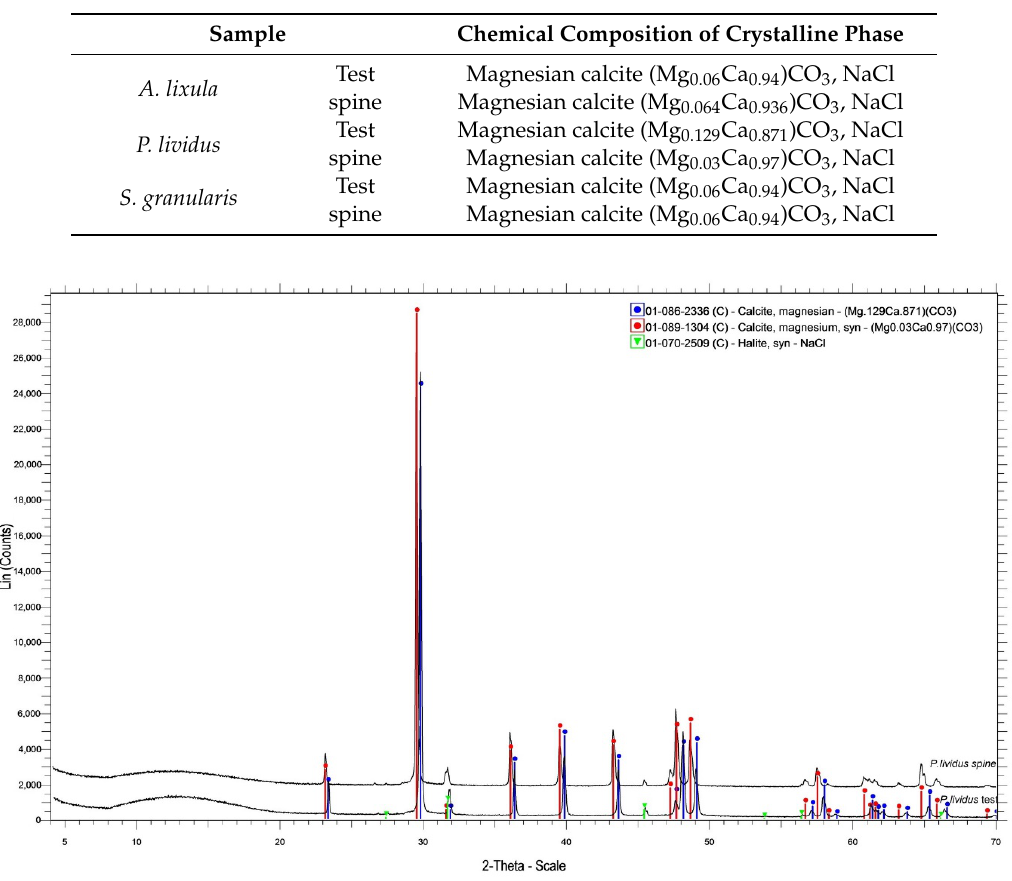
Figure 7. Representative powder XRD pattern of test and spines of P. lividus.